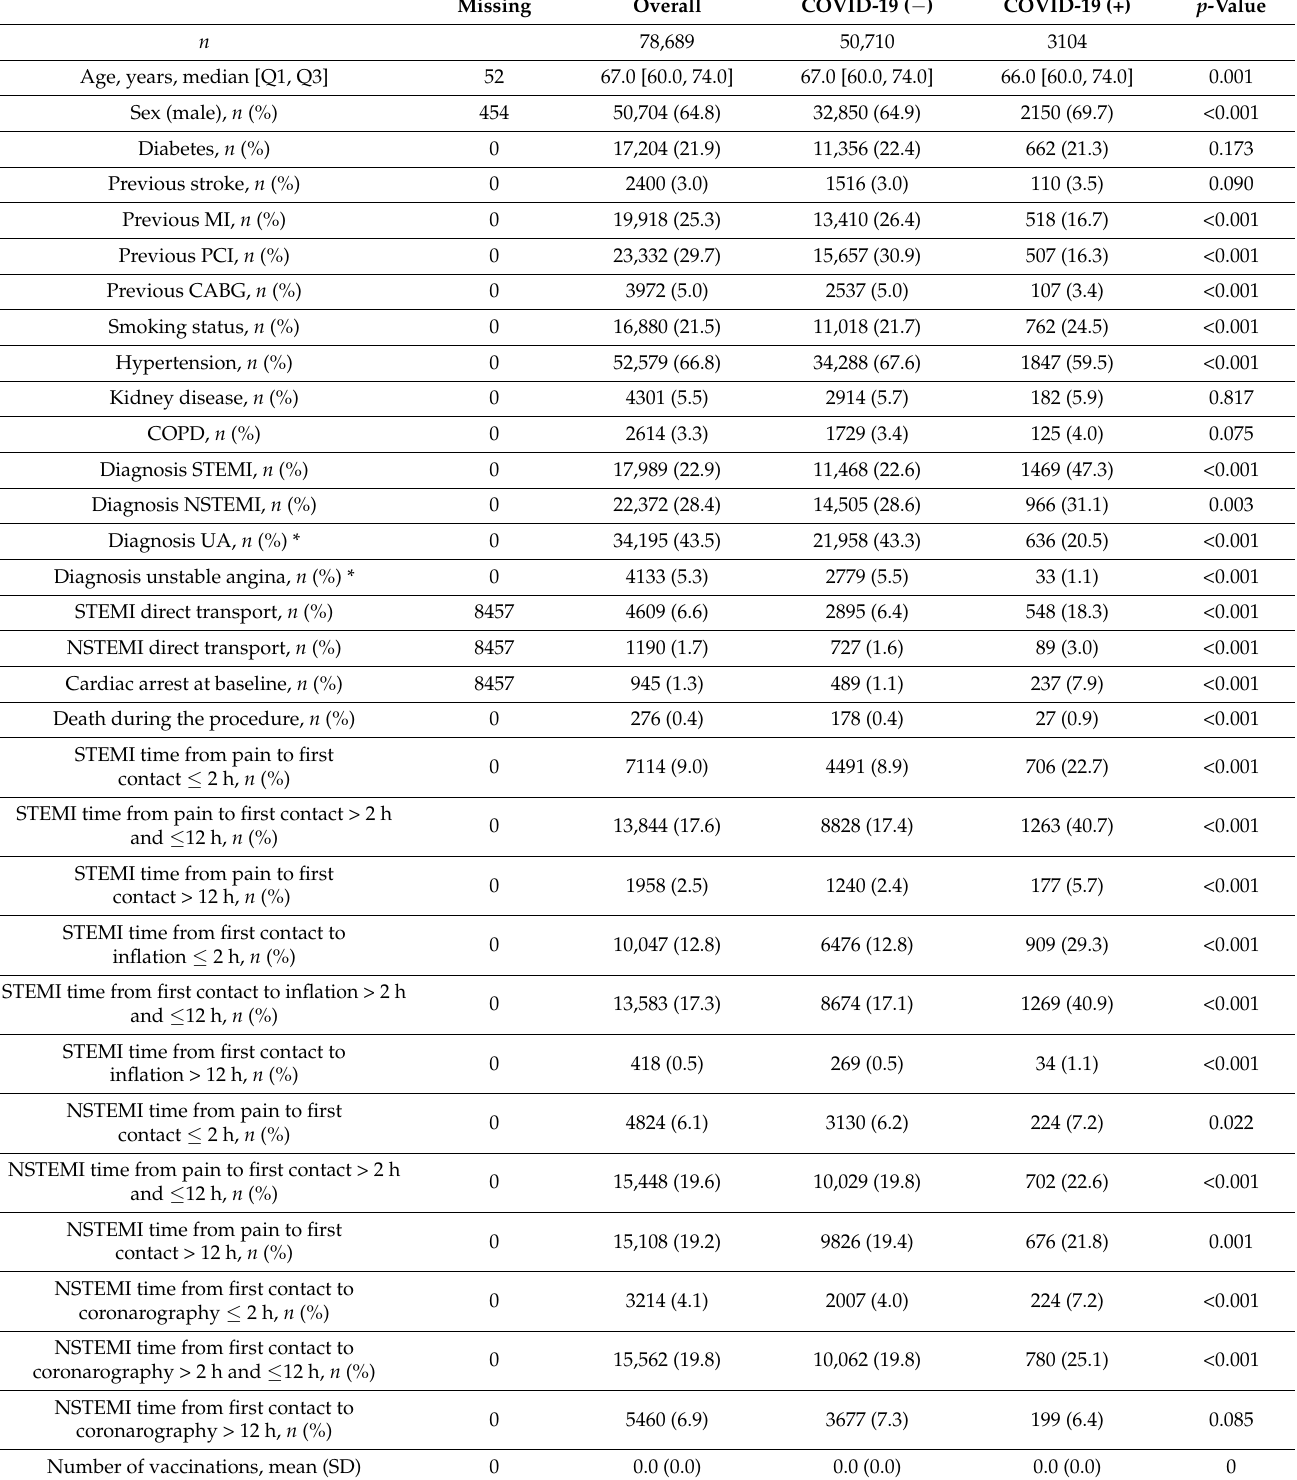
Table 1. Characteristics of patients analyzed in